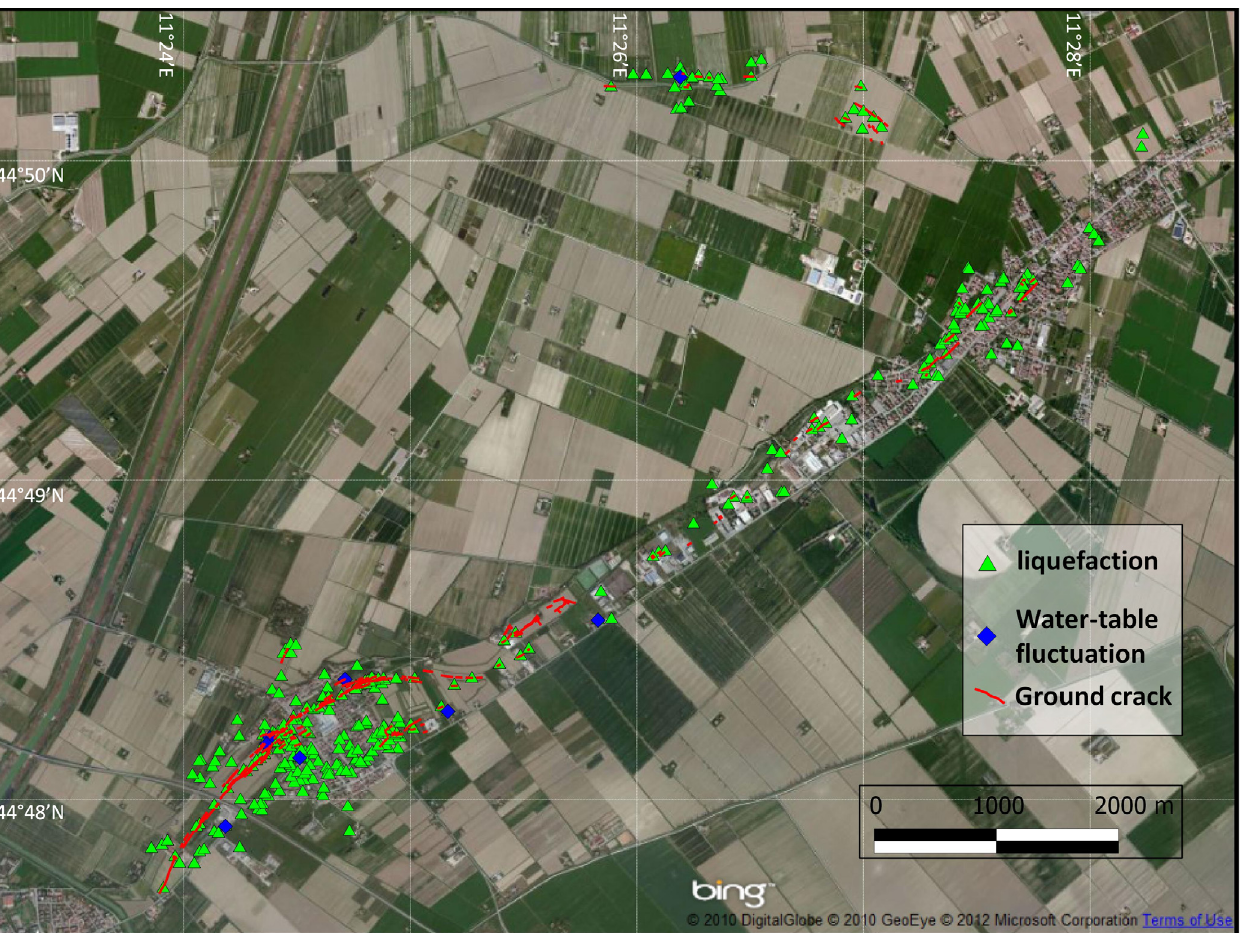
Figure 2. Liquefaction-type phenomena and ground ruptures between Sant'Agostino and Mirabello. These effects were distributed in a NE-SW-trending elongated area located on an ancient paleochannel of the Reno River. They heavily damaged private buildings and industrial plants located above it. Other effects were mapped in a WNW-ESE-trending elongated area located some kilometers northwest of the Mirabello village. These effects were found on a very flat portion of the floodplain, and were not directly linked to any ancient